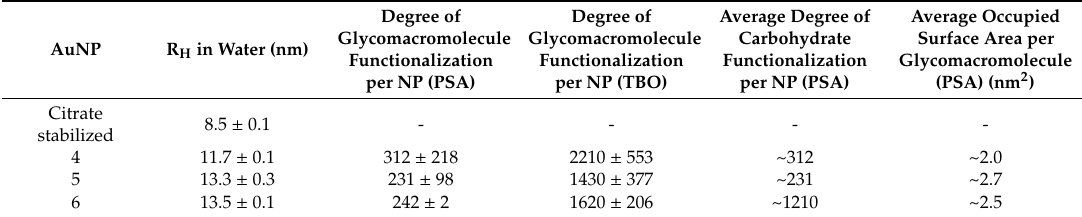
Table 1. The DLS derived hydrodynamic radii (R H ) and degree of glycomacromolecule functionalization determined by phenol sulphuric acid method (PSA) and Toluidine Blue O-Titration (TBO) and derived average degree of carbohydrate functionalization and occupied surface